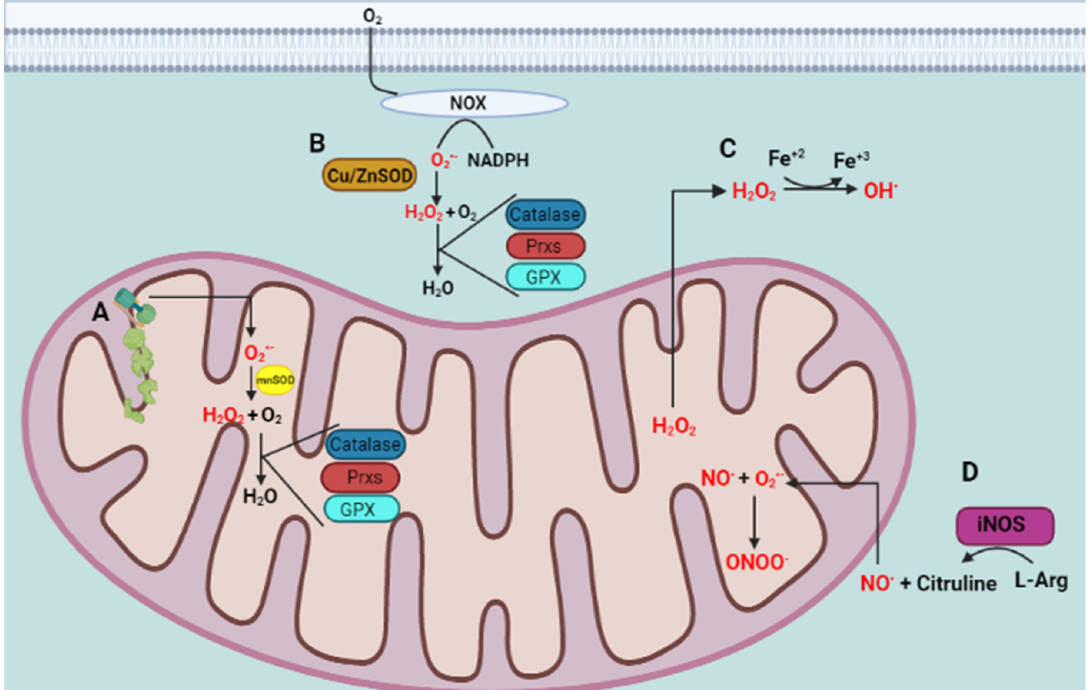
Figure 1. ROS and RNS generation. ( A ) The mitochondria are the main source of free radicals within the cell. The electron leakage in the electron transport chain (ETC) generates superoxide anion (O 2 •− ) in the mitochondrial matrix, where it is scavenged by MnSOD producing H 2 O 2 that, in turn, is detoxified by catalase, Prx, and GPx. ( B ) Another source of O 2 •− is the NOX enzyme family, which uses NADPH to reduce molecular oxygen to produce O 2 •− . The O 2 •− cannot cross membranes, but H 2 O 2 easily diffuses through them. ( C ) If H 2 O 2 concentration overcomes the enzymatic antioxidants activity, it reacts with transition metal ions such as iron, mediating the OH • formation by the Fenton’s reaction. ( D ) Nitric oxide synthases (NOS) catalyze the L-arginine oxidation producing L-citrulline and NO • . The latter can diffuse through membranes and react with mitochondrial O 2 •− producing peroxynitrite (ONOO − ), which diffuses to different cellular compartments causing RNS-mediated damage (figure created in BioRender.com accessed on 29 January